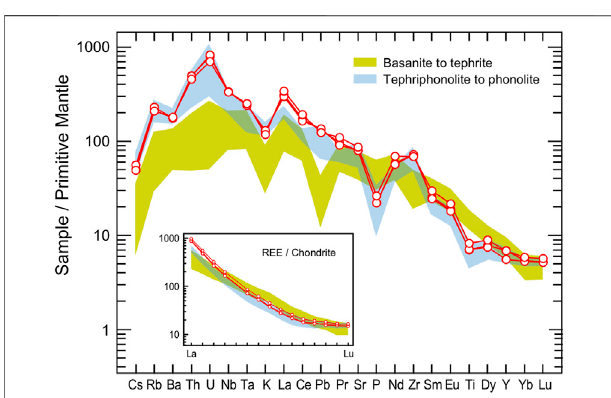
FIGURE 5 | Incompatible-element diagram for three tephriphonolite samplesofthisstudy,normalized toprimitivemantle.Rangeforbasanitesand tephrites (green), and tephriphonolites and phonolites (blue), from Cumbre Vieja are indicated for comparison; data sources as in Figure 4 . Inset showsthepronouncedconcave-upwardshapeofthesamplesinachondrite- normalizedREEdiagram. Normalization values arefrom Sunand McDonough